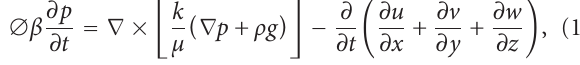
Figure 1: The right lung reconstructed from 4DCT scan dataset obtained at M.D. Anderson Cancer Center,